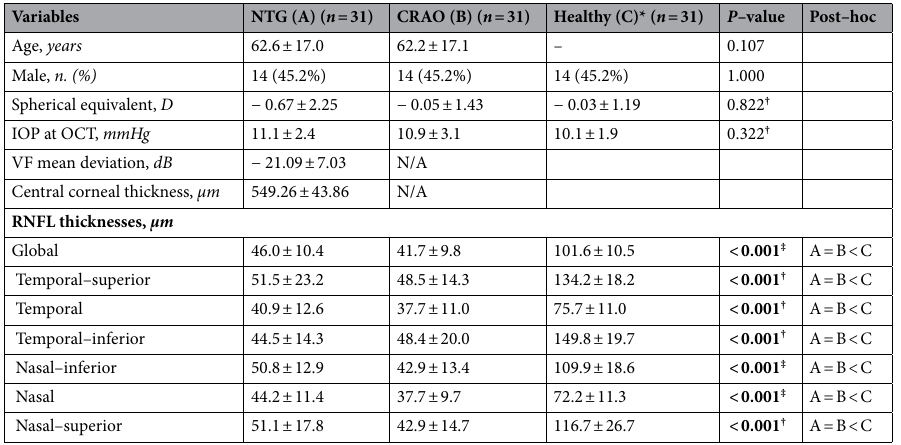
Table 1. Demographic and ocular characteristics of participants ( n = 93). Values are shown in mean ± standard deviation or n (%) values, with statistically significant P –values in boldface. NTG normal tension glaucoma, was performed using Kruskal–Wallis † and ANOVA ‡